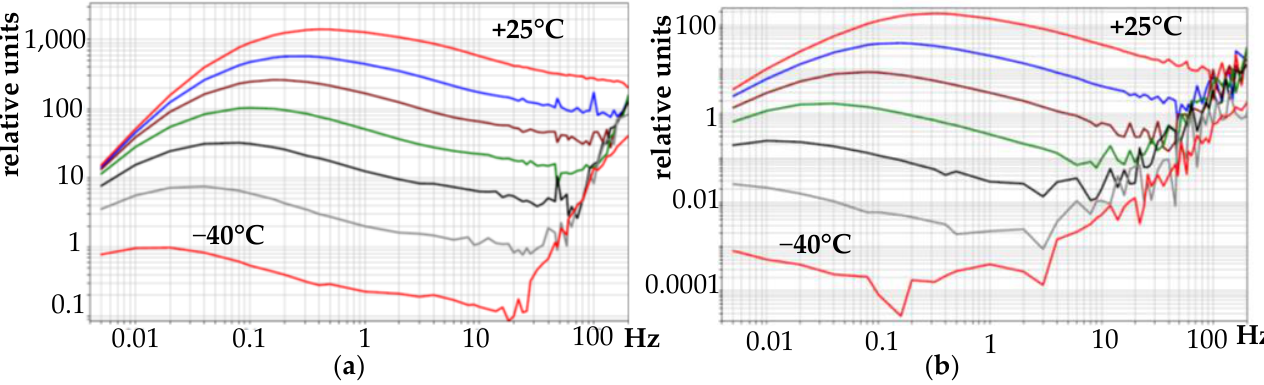
Figure 3. Families of amplitude-frequency characteristics of the studied samples depending on the ambient temperature (+25, +10, 0, −10, −20, −30, −40 °С ), along the abscissa axis there is Frequency in Hz, relative units along the ordinate axis proportional to V/m/sec: ( a ) For the electrolyte sample #1 [BMIM][I] /PC /LiI; ( b ) For the electrolyte sample #2 [BMIM][I] / Water/ LiI.